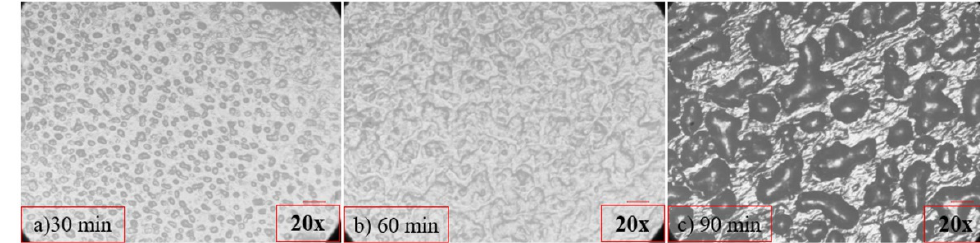
Figure 5. Optical Microscopy images of the suspension containing 1 wt.% SWCNTs after ( a ) 30 min, ( b ) 60 min, and ( c ) 90 min of the sonication process.